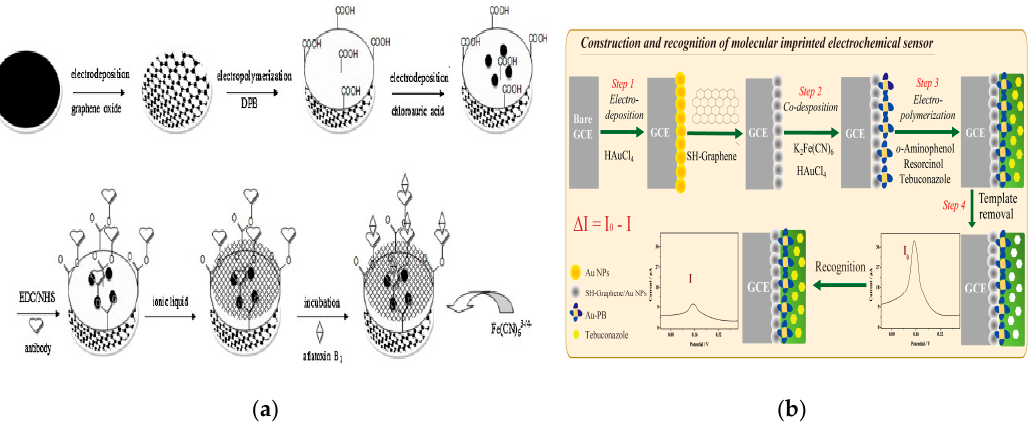
Figure 6. Application of GR combined with ionic liquid in electrochemical sensors. ( a ) GR/conductive polymer/AuNPs/ionic liquid membrane sensor for aflatoxin B 1 detection. Reproduced with permission from reference [147]. Copyright 2012 Elsevier. ( b ) The preparation procedure for MIP/Au-PB/SH-G/AuNPs/GCE. Reproduced with permission from reference [149]. Copyright 2018 Elsevier.